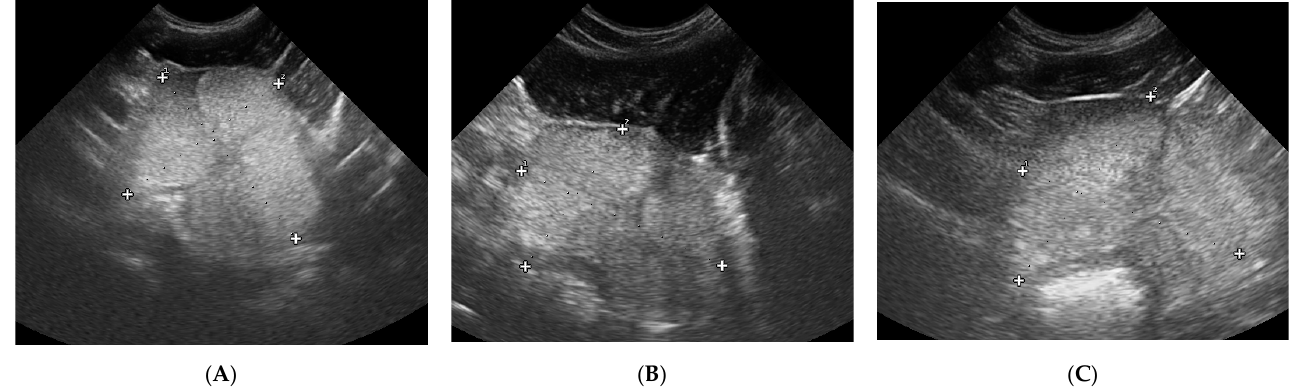
Figure 3. The B-mode prostate imaging in a dog receiving osaterone acetate, on days: ( A )—day 0; ( B )—week 8; ( C )—week 16; transverse view, the prostate gland is indicated in pictures.